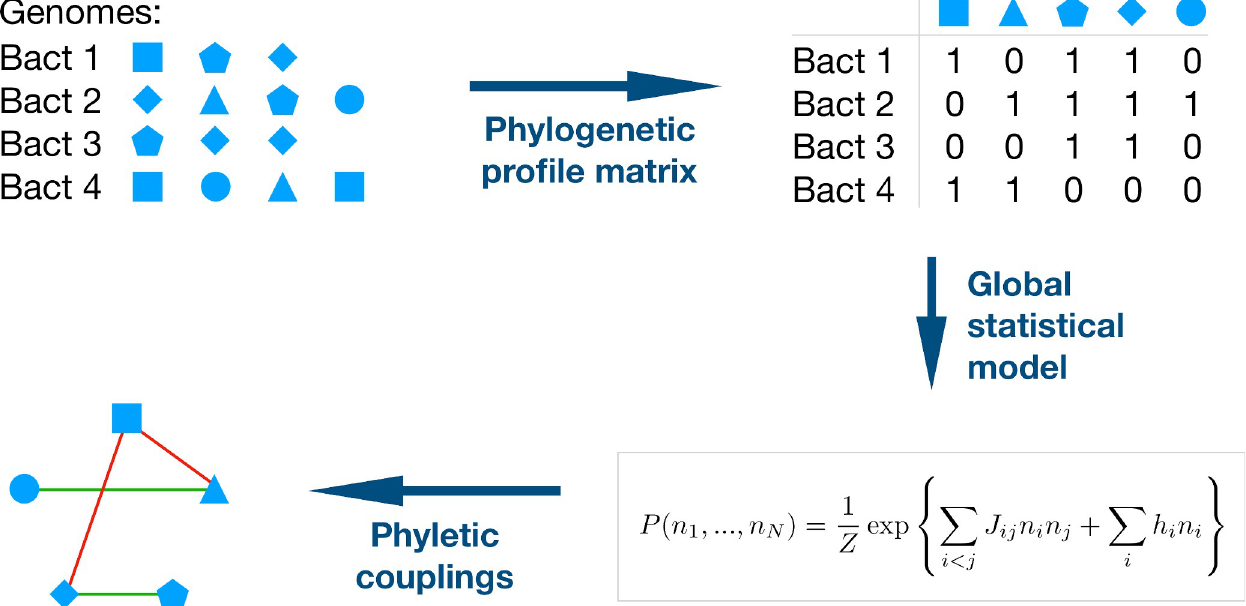
Fig 1. Schematic representation of the inference of phyletic couplings. – The composition of bacterial genomes in terms of protein families is extracted from the Pfam database. The presence and absence of each family is coded into the binary phylogenetic profile matrix (PPM); note that this matrix does not account for the presence of multiple paralogs of a domain. The statistics of the PPM is reproduced by a global statistical model P ( n phylogenetic profile, the model corresponds to a lattice gas model in statistical physics. The strongest positive couplings (favored domain-domain co- occurrence) are expected to stand for positive relationships between domains, like domain-domain interactions or genomic co-localization. Negative couplings (avoided co-occurrence) is expected to indicate alternative solutions for the same biological function, like in cases of domain families in a common Pfam clan, or for convergent